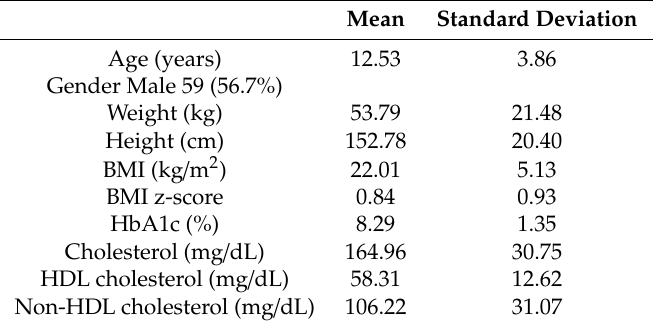
Table 1. Demographics and laboratory characteristics of study